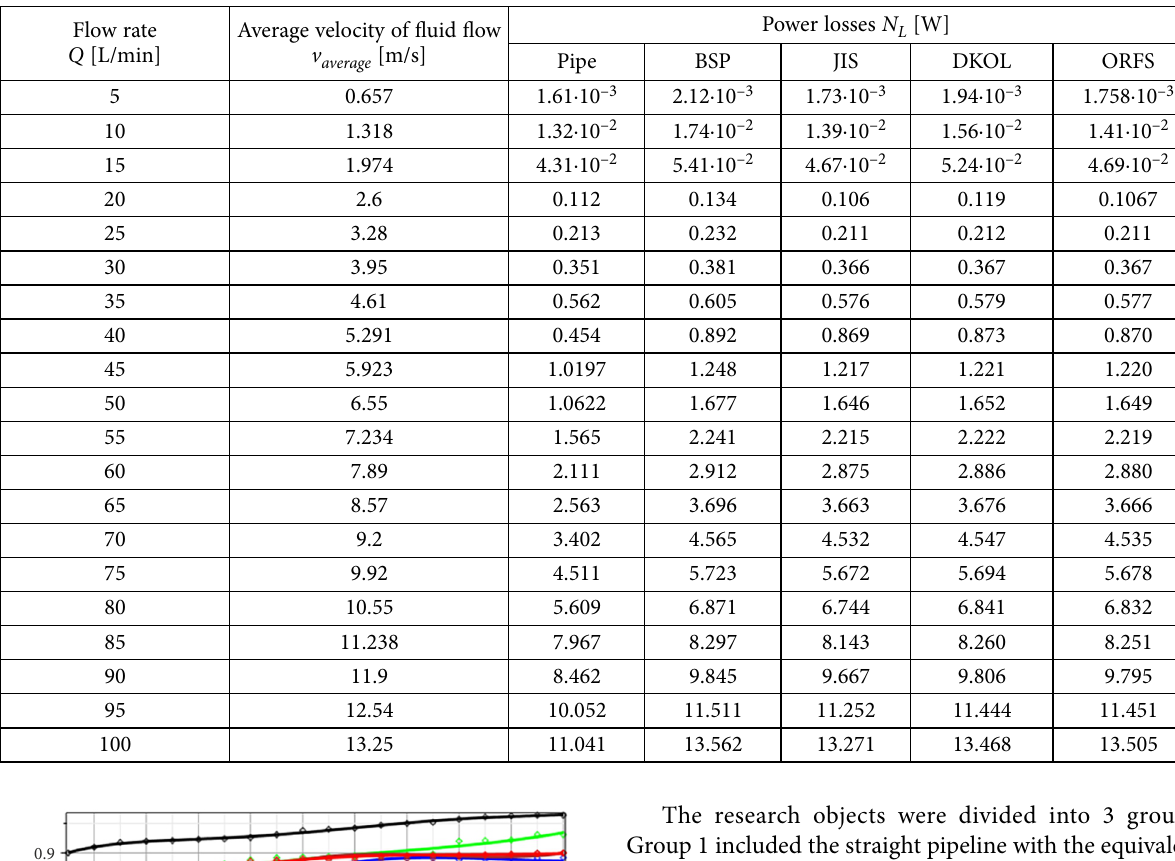
Table 9. Power losses of each standard of fitting connections